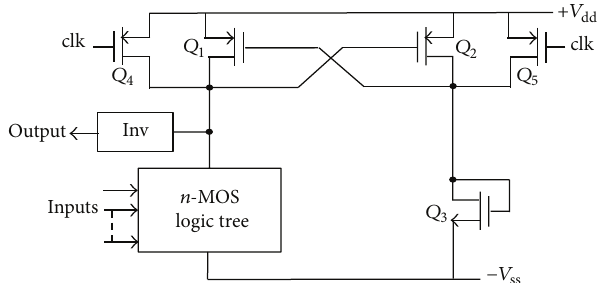
Figure 5: Schematic of proposed circuit using DCVS logic.